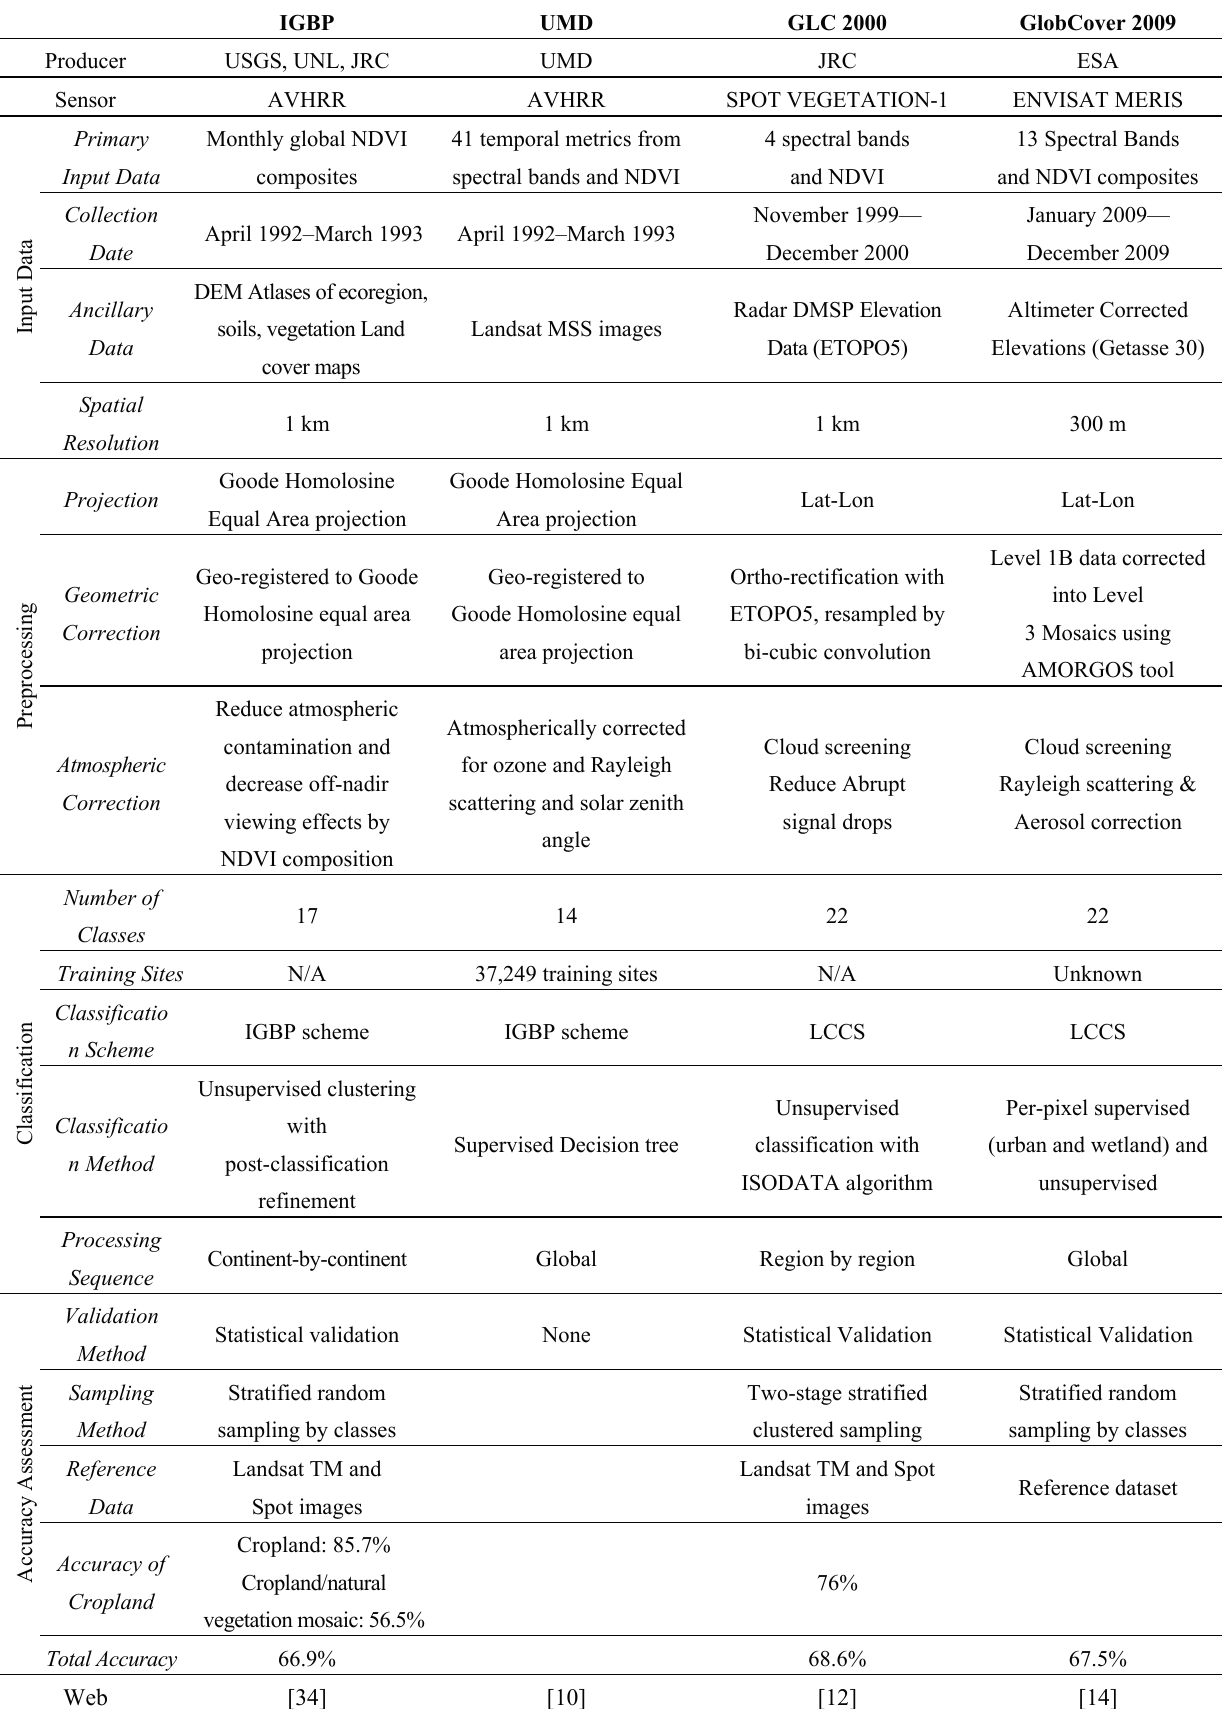
Table 2. Summary of the characteristics of global land cover mapping